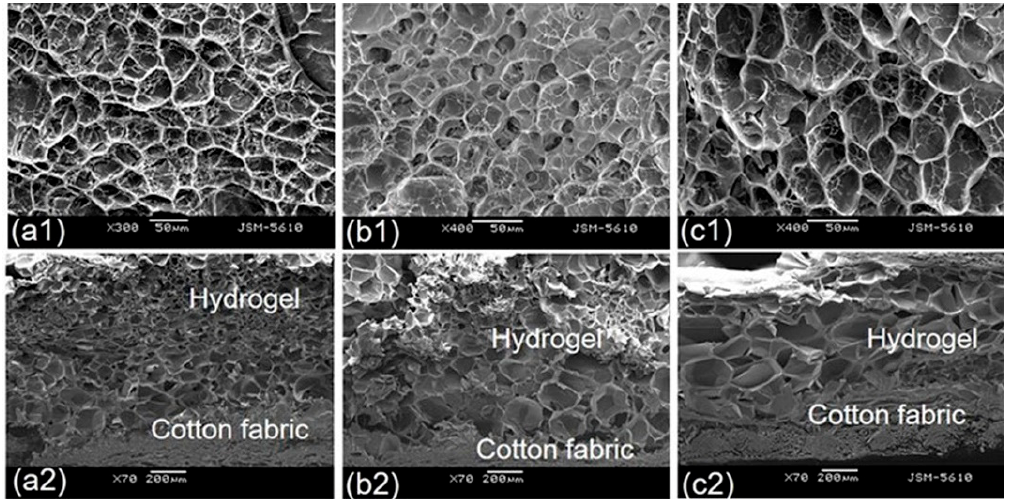
Figure 12. Scanning electron microscopy (SEM) images of the top view ( a1 – c1 ) and the cross section ( a2 – c2 ) of cotton fabric grafted with alginate-Ca 2+ /P(NIPAAm- co -EGMA 360 ) hydrogels. The monomer ratios of NIPAAm to EGMA 360 are ( a1 , a2 ) 20:0, ( b1 , b2 ) 19.5:0.5, and ( c1 , c2 ) 18.5:1.5.